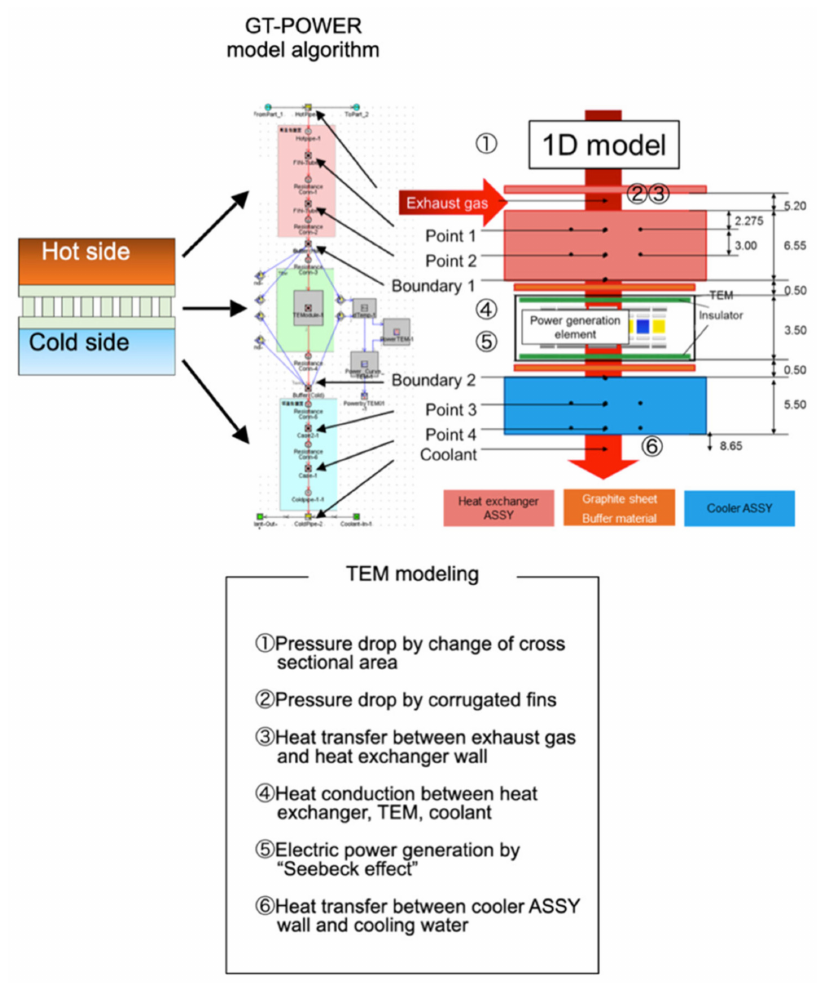
Figure 10. A one-dimensional model of the waste heat power generation unit in GT-POWER. In a typical combustion engine, the temperature of the exhaust gas decreases from the upstream part closer to the engine to the downstream part, by an amount in the range of about 373 to 973 K depending on the engine load, so it is necessary to select a TEM that operates in this temperature range and has durability. A single type of TEM that can cover the whole temperature range is still under development. For this reason, a tandem TEM arrangement in the waste heat power generation unit, which is composed of two TEMs working in the medium-temperature range from 573 to 973 K (MT-TEM) and the low-temperature range from 373 to 523 K (LT-TEM), was arranged in series in the gas flow direction as a practical solution. A Mg 2 Si element consisting of a unileg (n-type)